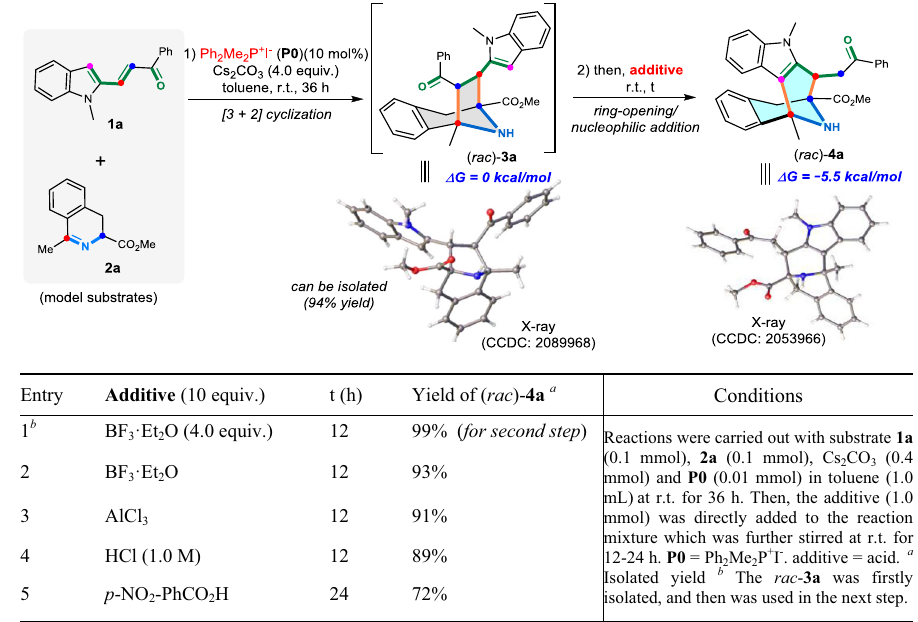
Fig. 2 Initial investigations on the feasibility of this cascade process. The annulation reaction between N-methylated 2-alkenylindole 1a and benzyl-fused cyclic azomethine ylide 2a in the presence of racemic dimethyldiphenylphosphonium iodide catalyst P0 under standard PTC conditions was tested, and then different types of acids towards promoting the further ring-opening/ring-expansion process was